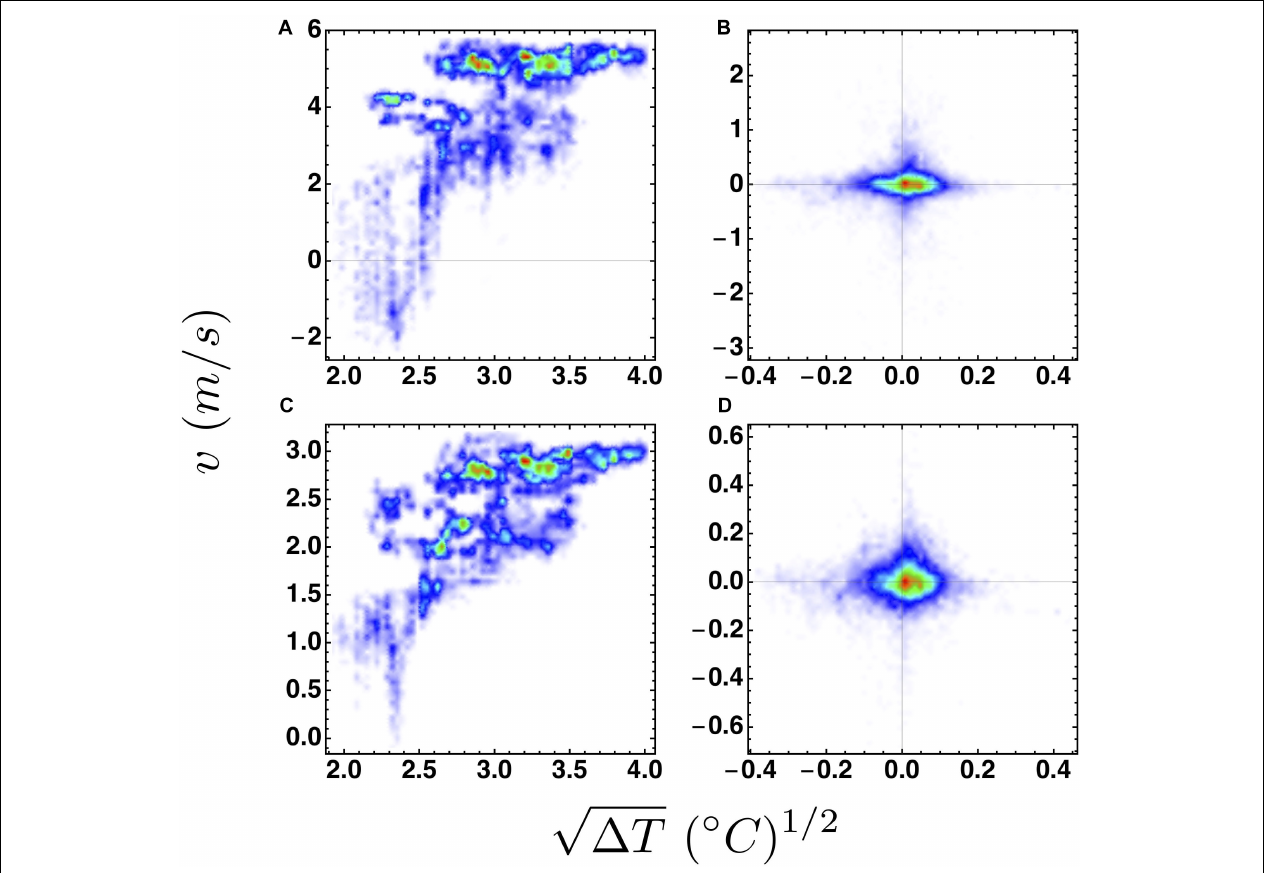
√ (cid:49) T data recorded at the Eolo (A) and the Serpente √ (cid:49) T signals sampled at the Eolo (B) and the Serpente (D) entrances. De-trending was obtained using a